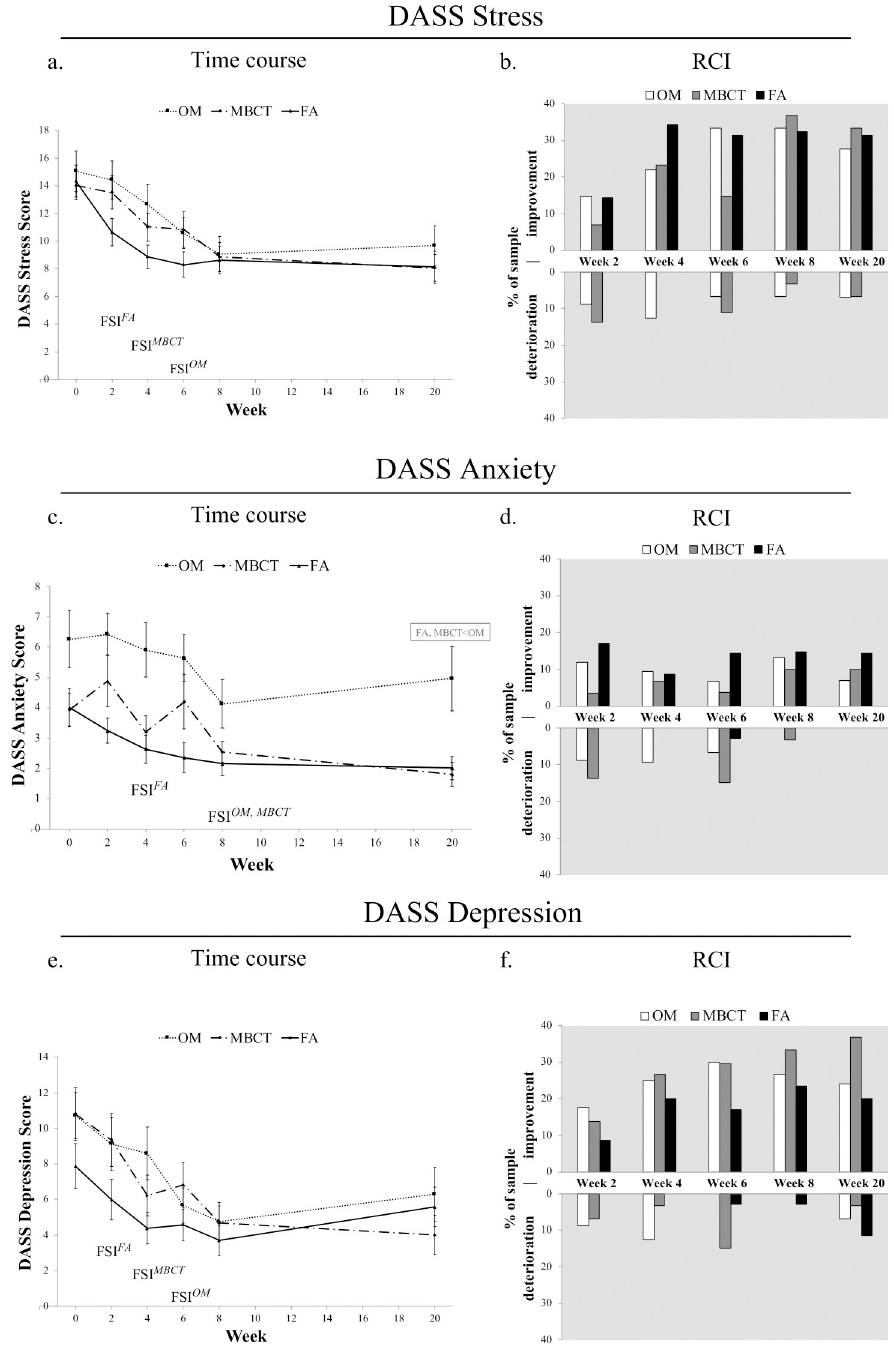
Fig 3. Differential treatment effects and clinically significant changes in stress, anxiety and depression (DASS). (a, c,e) Group means (symbol) and standard error (error bars) at weeks 0, 2, 4, 6, 8 and 20 in intent-to-treat regression analysis ( n = 104). Gray text boxes denote statistically meaningful between-group differences ( d > 0.30). (b,d,f) Reliable change index (RCI) at each timepoint relative to baseline scores. Upward and downward bars signify % of each treatment sample showing clinically significant improvements and deteriorations, respectively. Percent of sample with no reliable change is not shown (see S1 Appendix).